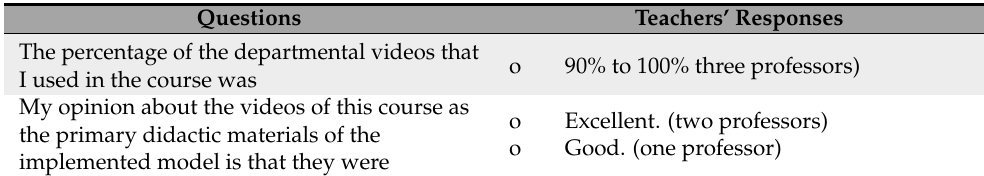
Table 9. The three participating teachers’ opinions about the course taught in the virtual flipped classroom model, supported by videos from the YouTube social